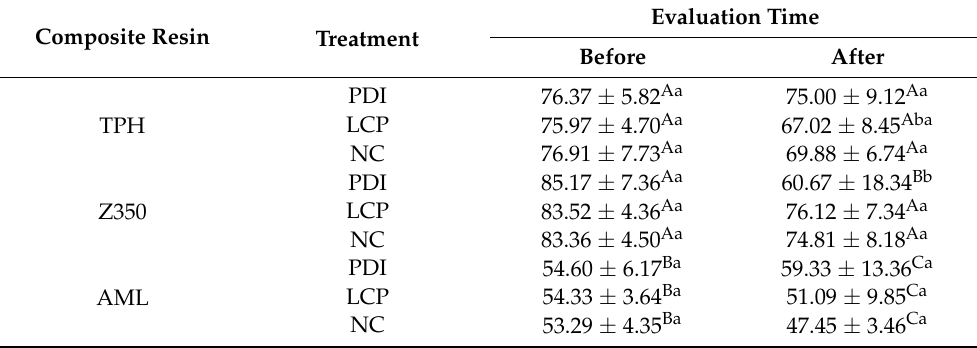
Table 3. Mean values ( ± standard deviation) of hardness values as per the Vickers test (in kgf) obtained before treatment and after treatment (PDI: photodynamic therapy; LCP: Liquid crystal precursor without curcumin; NC: negative control/artificial saliva) and organized by composite resin (TPH, Z350, and AML). Composite Resin Treatment